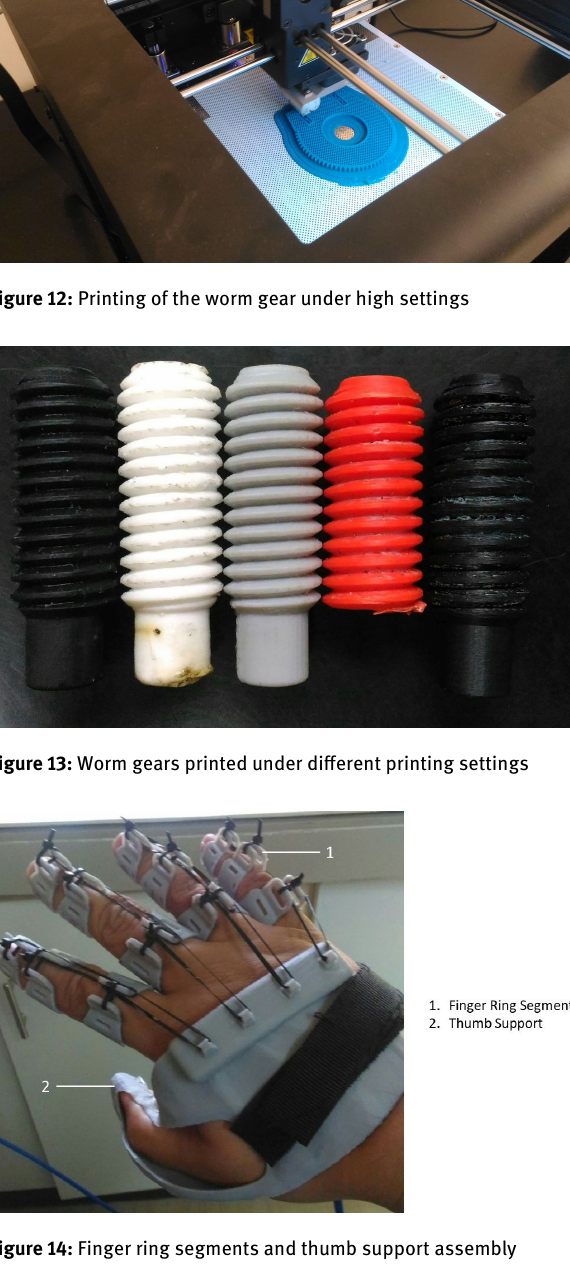
Forms 2, Ultimaker PC, Creator Pro, Zortax HD, Zortrax Std (from left to right in the picture).